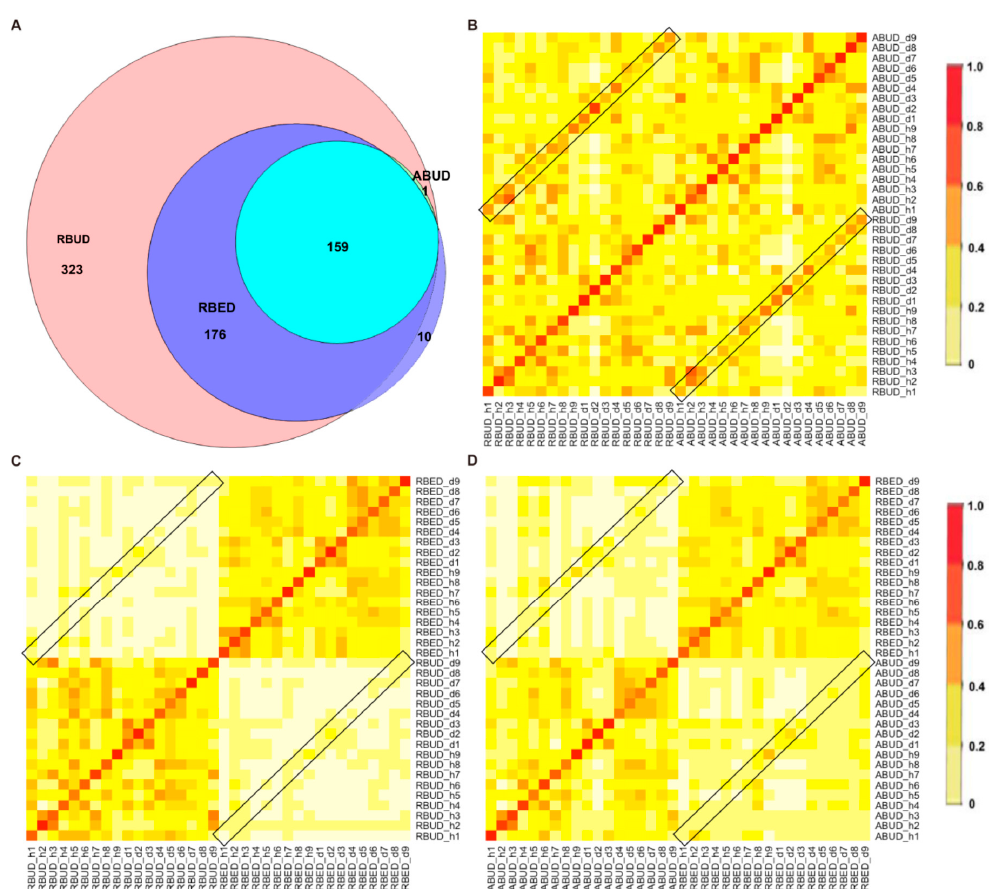
Figure 4. Changes of the microbial community detected by the three methods between healthy group and avian colibacillosis group. ( A ) Venn Diagram showed the specific and the common bacterial species identified by RBUD, ABUD and RBED. ( B ) Species similarity between RBUD and ABUD using Bray–Curtis similarity matrix correlation analysis. The box represents the similarity of bacteria species in the same sample using different methods. ( C ) Species similarity between RBUD and RBED using Bray–Curtis similarity matrix correlation analysis. ( D ) Species similarity between ABUD and RBED using Bray–Curtis similarity matrix correlation analysis.